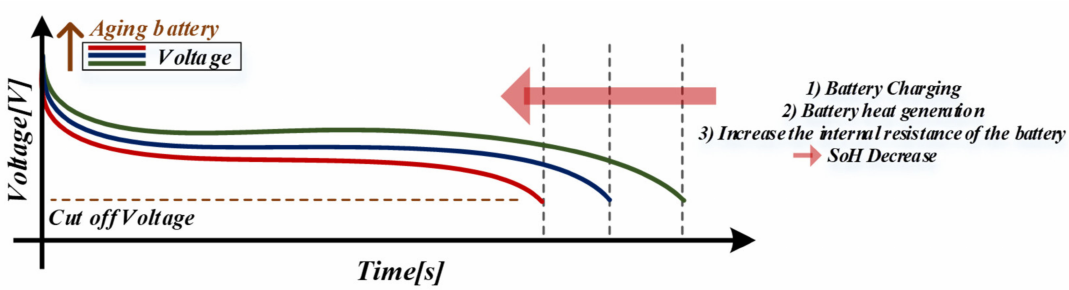
Figure 8. Voltage and SoH of a battery during